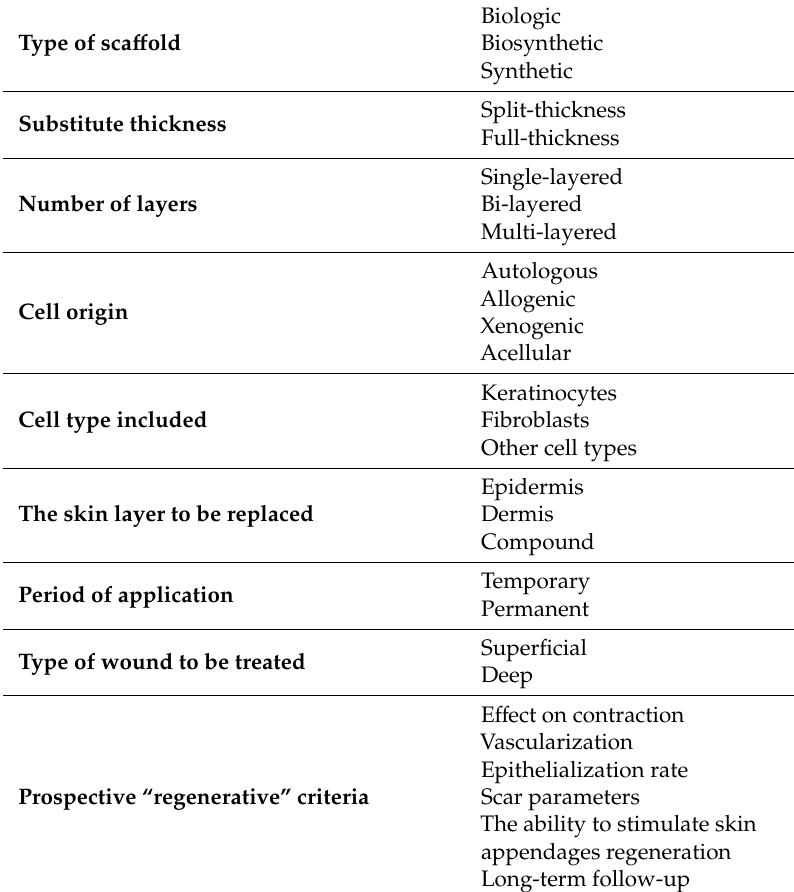
Table 2. Criteria for skin substitutes